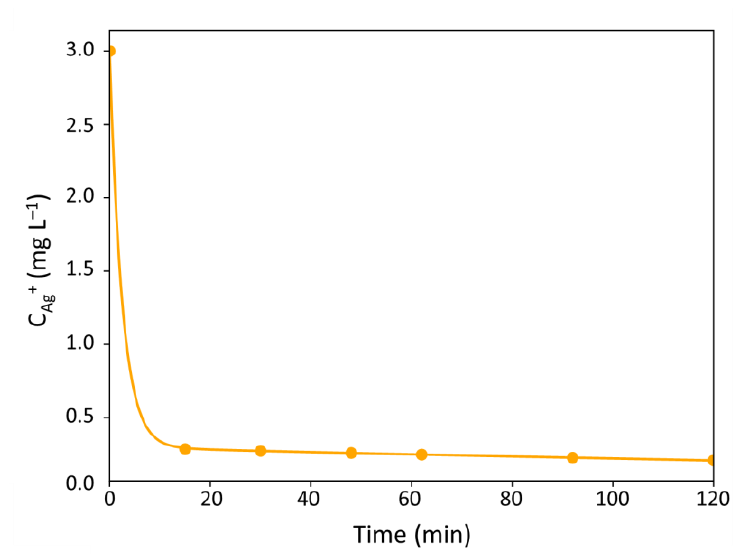
Figure 6. Haas and Karra model: concentration profile of Ag + ions with time. Based on this curve (Figure 6), the bacterial removal can be divided in three zones: First zone: Ag + ions are fully available (C Ag+ ≃ C Ag0+ ) and the flow of inactivated bac-